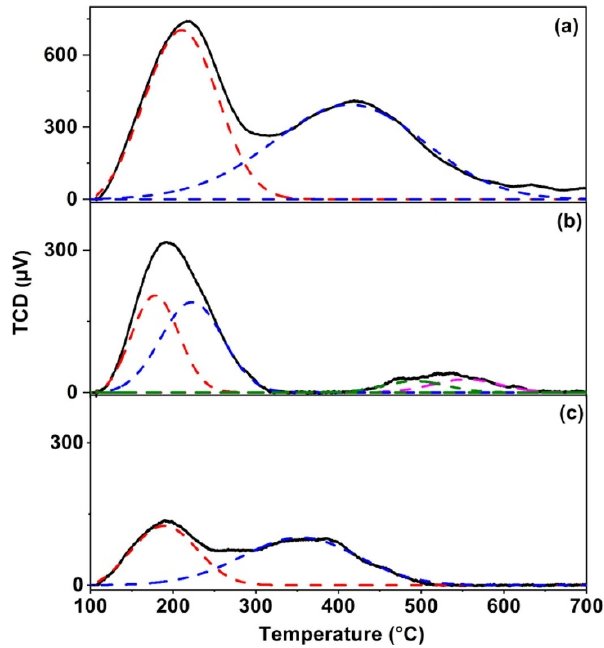
Figure 6. NH 3 -TPD profiles of ( a ) isolated ZSM-5 zeolite, ( b ) hierarchical ZSM-5@Silicalite-1 nanosheet composite, and ( c ) conventional ZSM-5@Silicalite-1 material. Reprinted with permission from [75] . Copyright 2020 Elsevier.